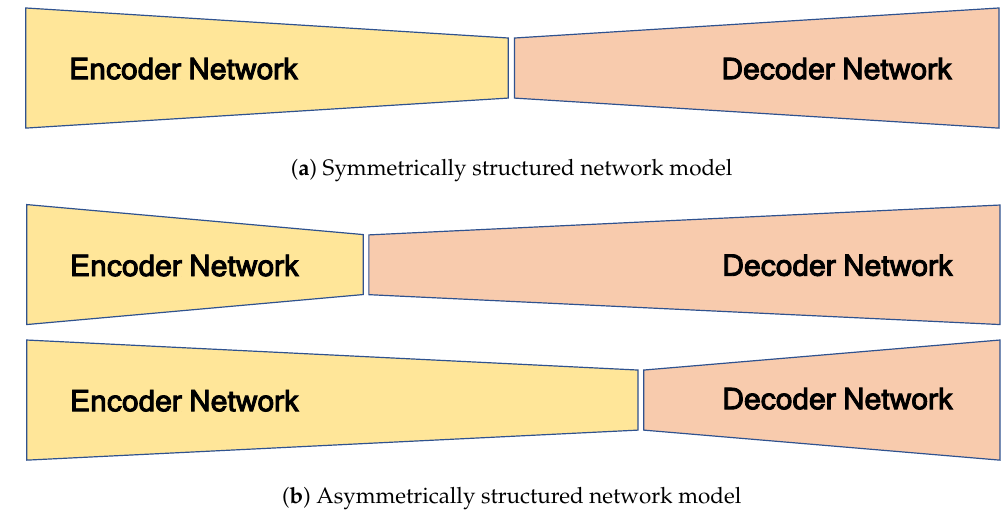
Figure 4. Encoder-Decoder-structured FCN